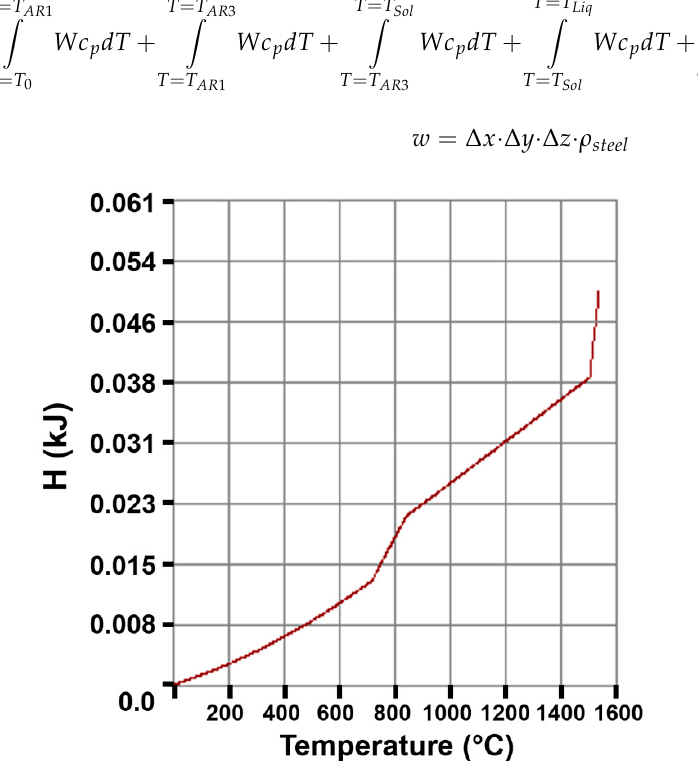
Figure 2. Relationship between enthalpy and temperature for a steel billet [23].